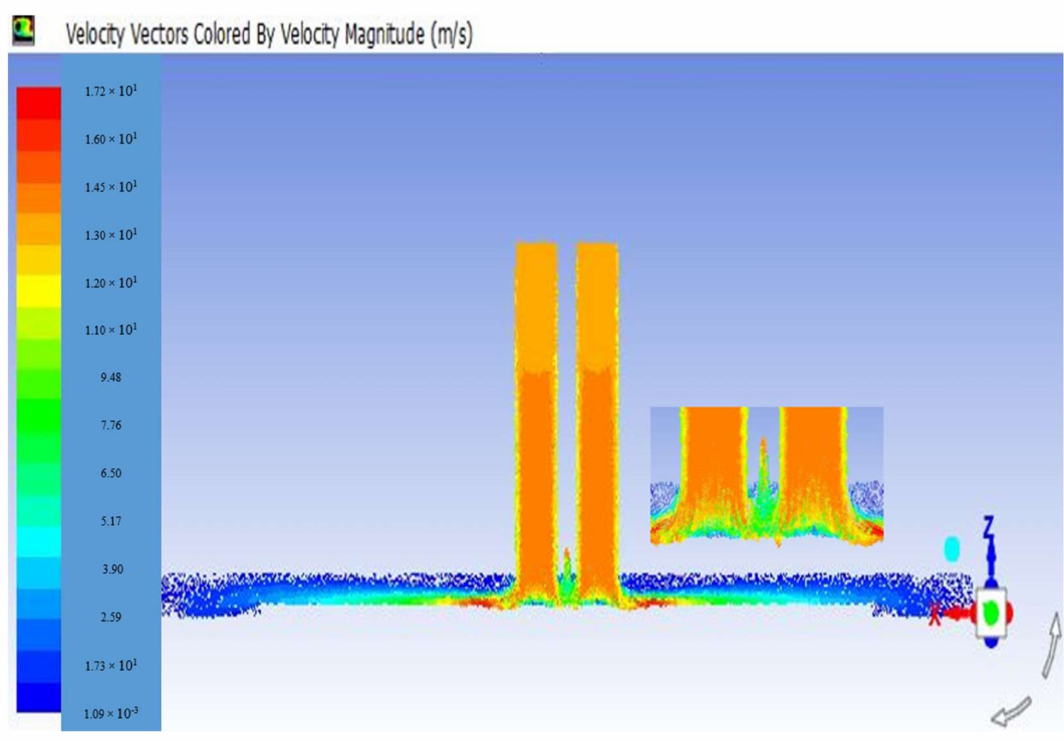
Figure 13. Velocity vectors colored by the velocity magnitude for the twin impingement jet mechanism at the Nozzle-Nozzle spacing equal to 1 cm and the Nozzle-Plate distance equal to 1